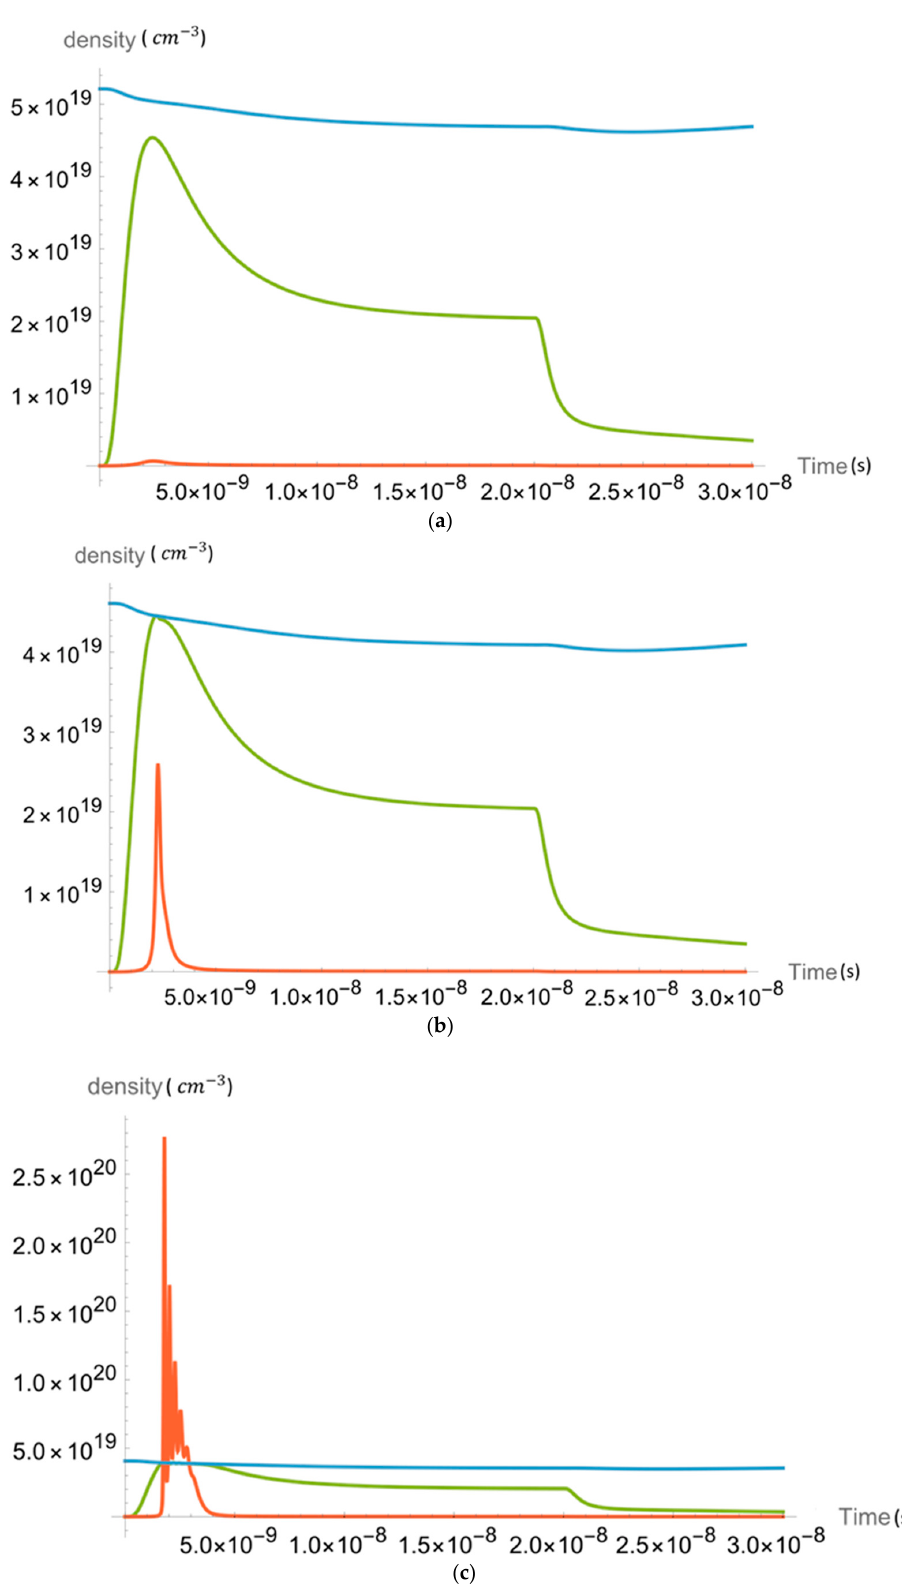
Figure 5. Time evolutions of the photon density P HO 10 6 (red), singlet density N SD 10 2 (green) and threshold density N SD | (blue; see (11)) for ( a ) below threshold Q = 1700, ( b ) at threshold Q = 2200 and ( c ) above threshold Q = 3000. In each case the pump current density is 2 kA/cm 2 and applied from 0 to 20 ns while β sp = 3 × 10 − 4 Table 2. Model Parameters for Figure 3.